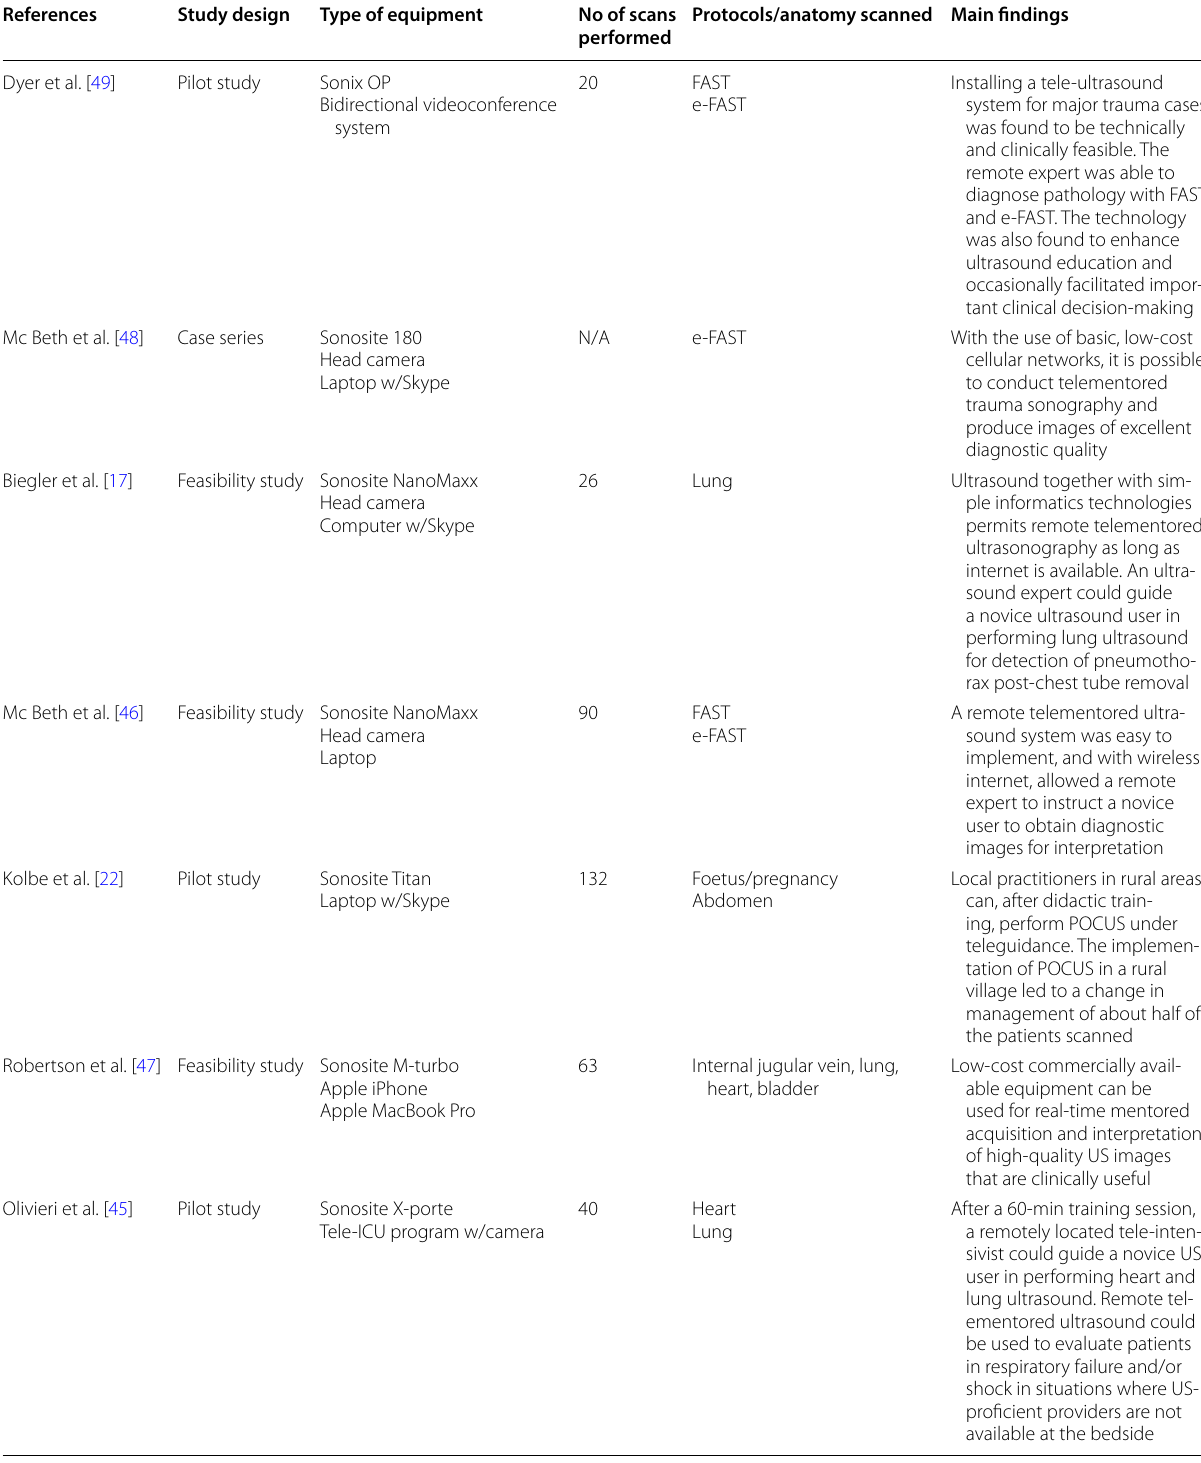
Table 4 Selection of articles showing the use and effect of